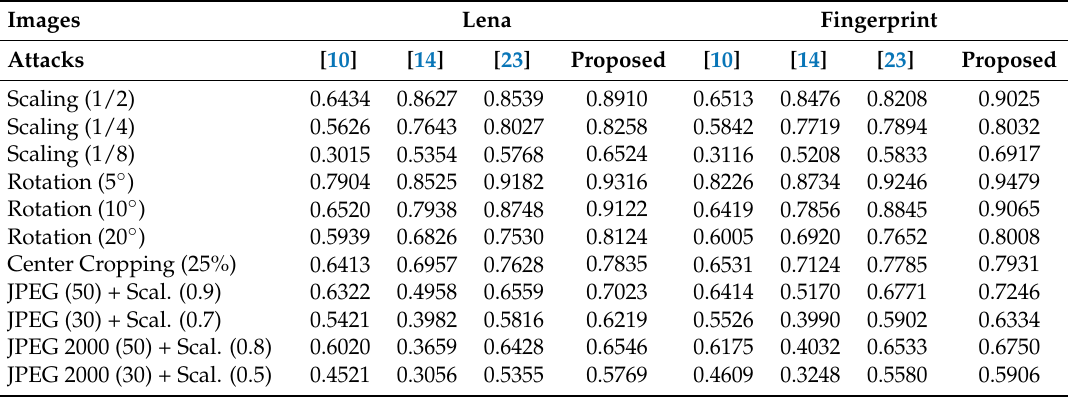
Table 4. The results of attack under geometric distortions